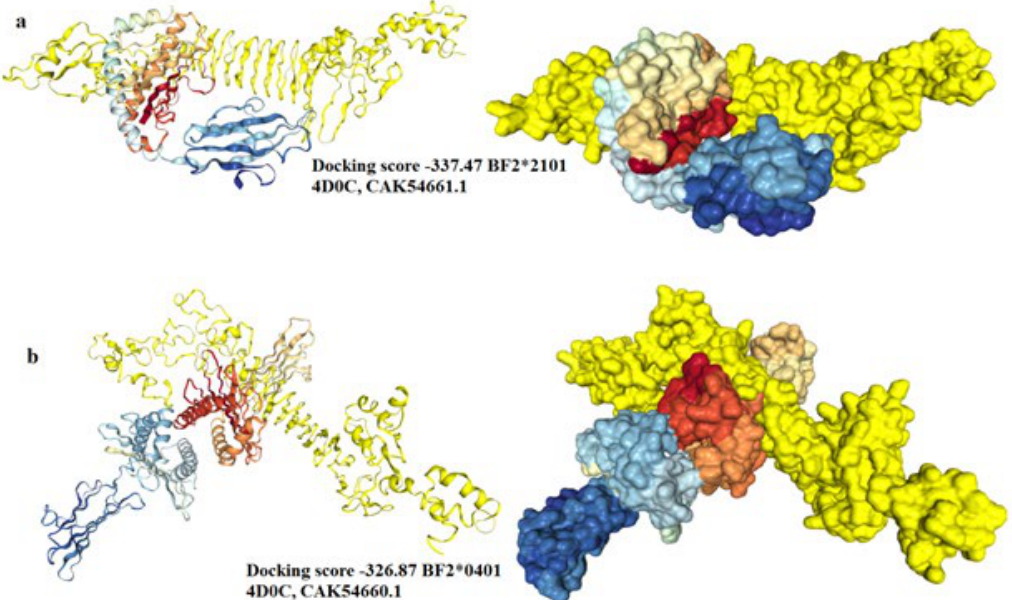
Fig. 9. Molecular docking between the vaccine protein and the chicken MHC1 alleles (a) BF2 * 2101 and (b) BF2 * 0401. The vaccine construct was shown in yellow colour and the chicken alleles in rainbow colours. A cartoon structure of the vaccine construct docked with BF2 * 2101 was shown in Fig. (a-left) while the ball structure in (a-right). A cartoon structure of the vaccine construct docked with BF2*0401 was shown in Fig. (b-left) while the ball structure in